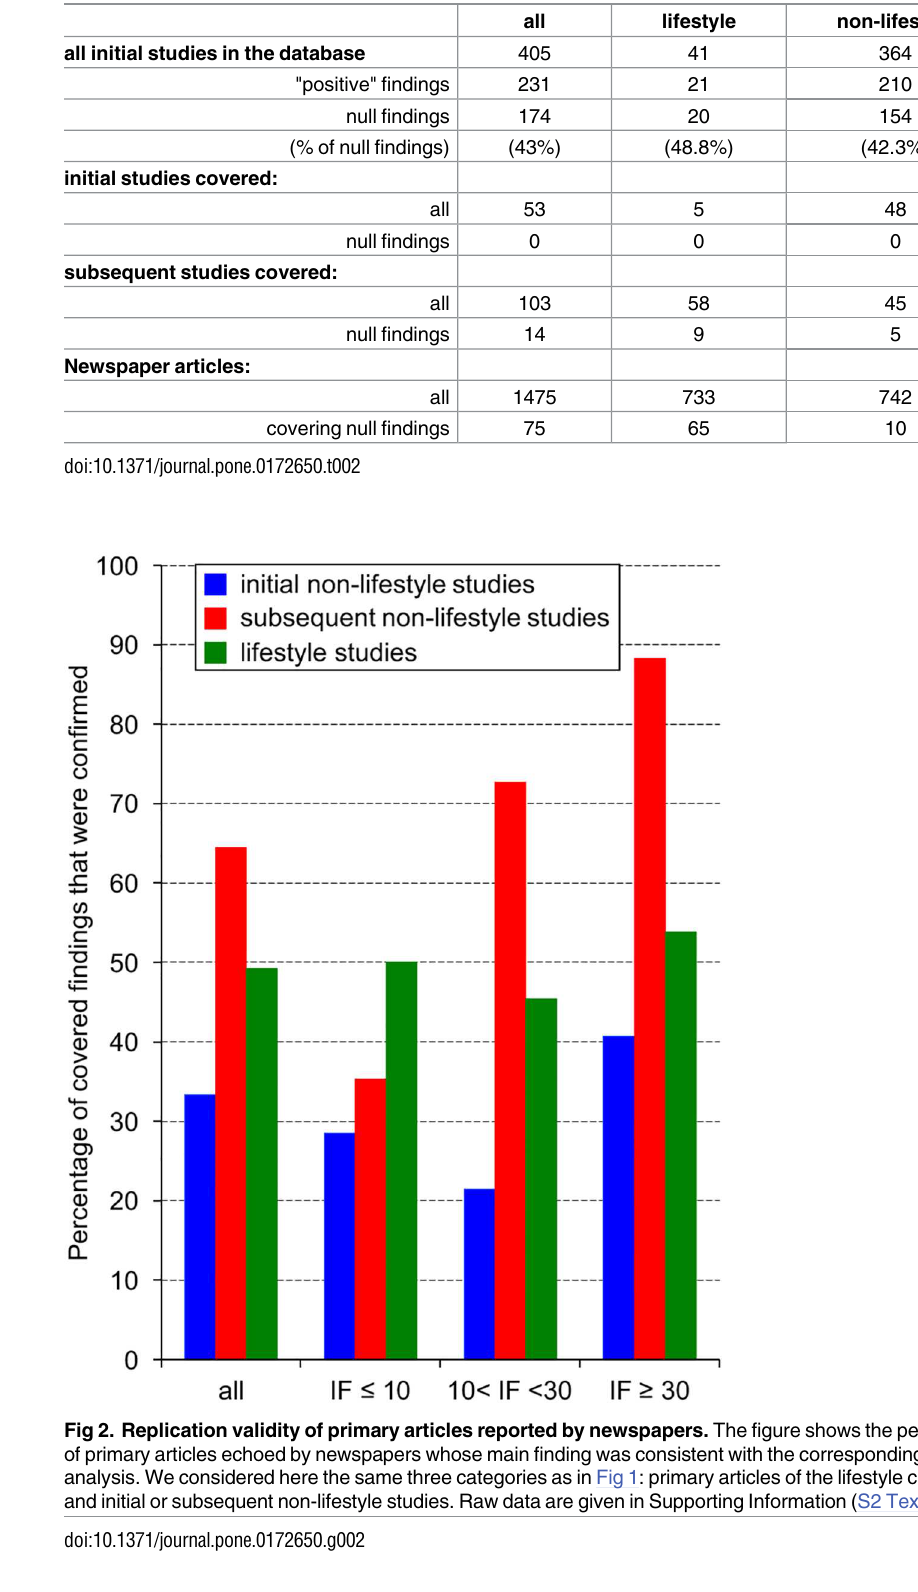
Table 2. Newspaper coverageof primary studies reporting null findings.